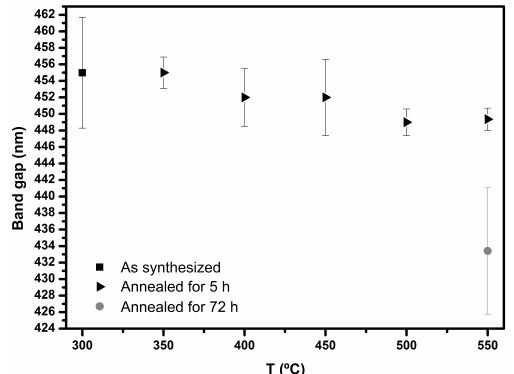
Figure 4. Reflectance maximum after heat treatments at different temperatures. Error bars: standard deviation of the mean value of the measurement of five different spots on each sample. Values were measured from 6 samples for the cases of both as-synthesized and 72h treatment, and the rest of the values were measured from 2 samples for each